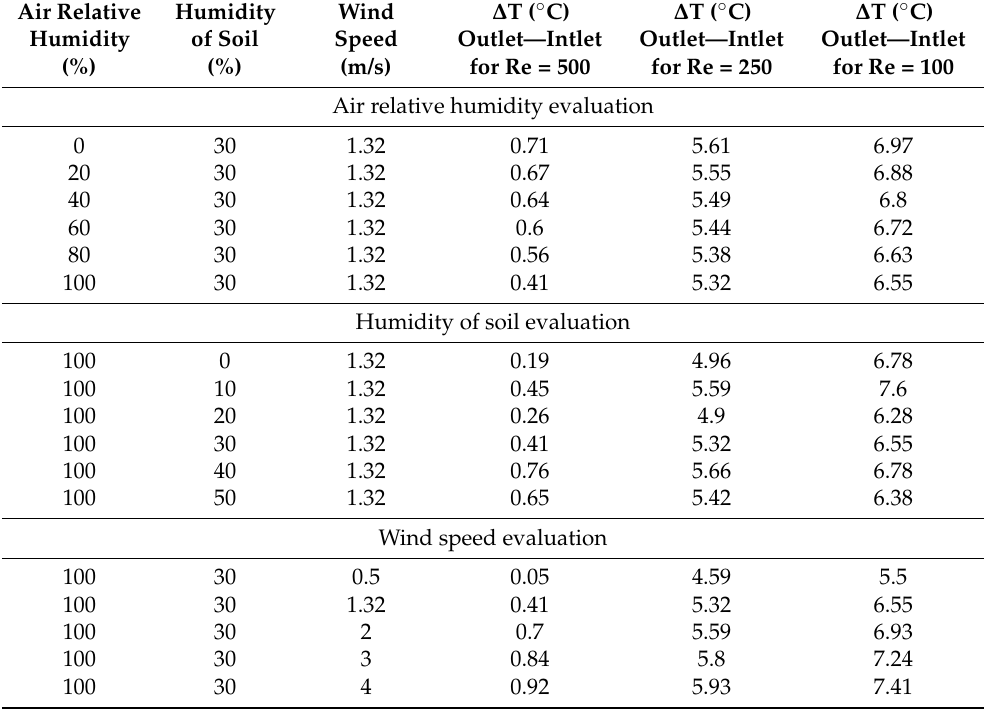
Table 14. Numerical evaluation of the heating potential according to the climatological conditions of the